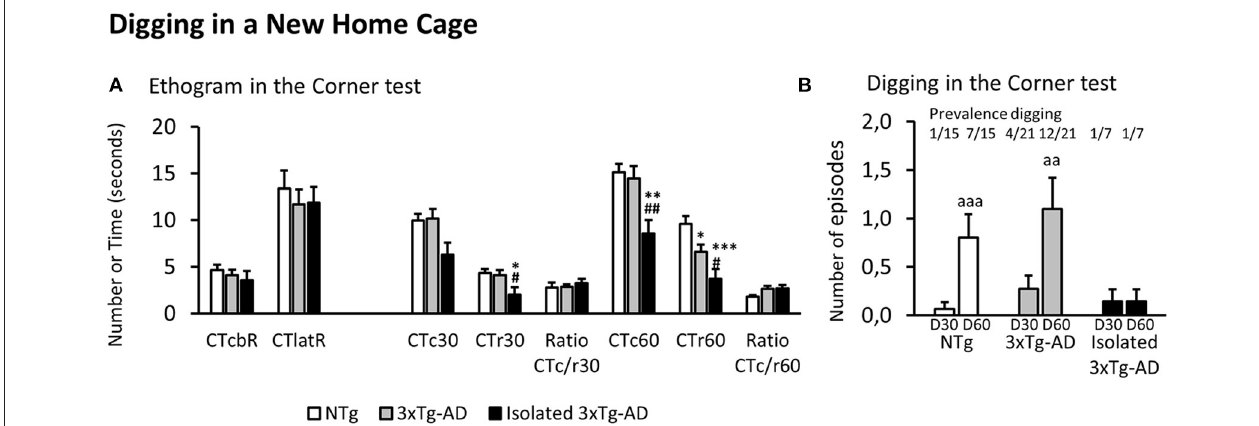
FIGURE 1 | Ethogram and Digging in a new home cage (Corner test). Results are expressed as mean ± SEM. (A) Ethogram in the corner test: CTcbR, visited corners before the first rearing; CTlatR, latency of rearings in seconds; CTc n , visited corners at n s; CTr n , rearings at n s; Ratio CTc/r n, ratio visited corners divided by rearings at n s of the test. (B) Digging in the corner test at 30 (D30) and 60 (D60) s. Statistics: One-way ANOVA followed by post-hoc Duncan’s test, * p < 0.05, ** p < 0.01, and *** p < 0.001 vs. the NTg group; # p < 0.05 and ## p < 0.01 vs. the 3xTg-AD mice. Paired t -test, aa p < 0.01 and aaa p < 0.001 vs. the same group at 30s.